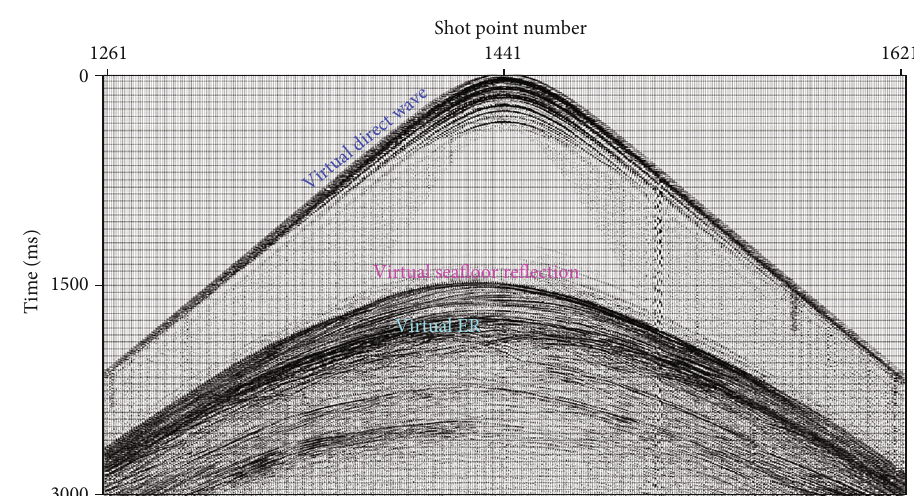
Figure 4: Virtual shot gathers obtained by correlating receiver ghost re fl ection with the direct